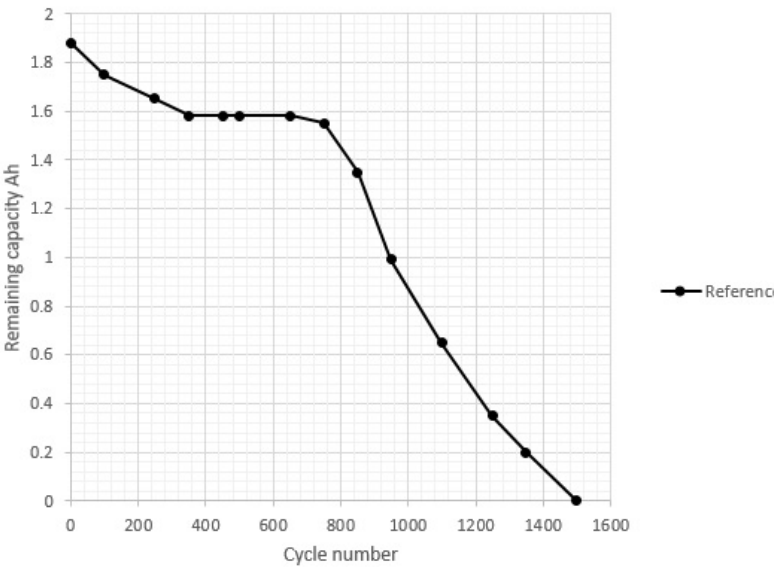
Figure 4. One cell’s degradation over